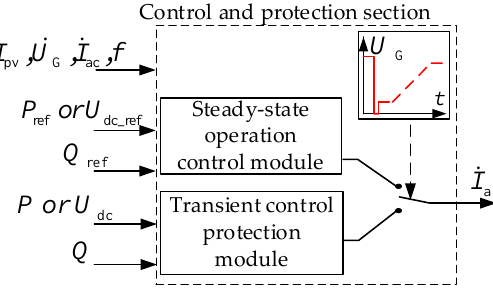
Figure 4. Inverter control and protection model.